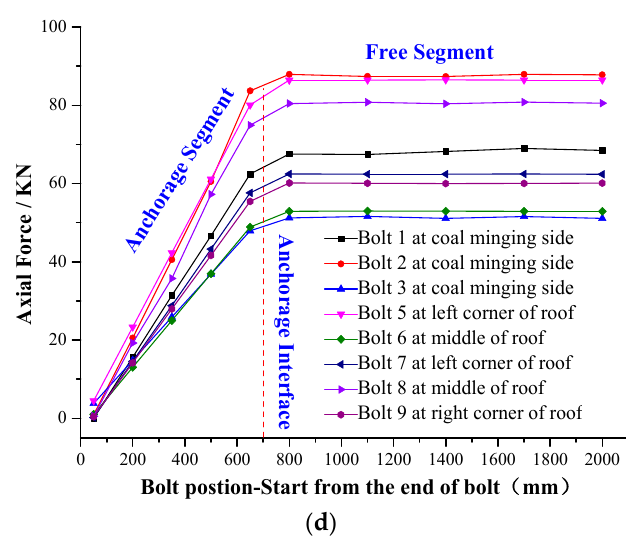
Figure 10. ( a ) Axial force variation curve of FBG force measuring bolt at coal mining side. ( b ) Axial force variation curve of FBG force measuring bolt at roof. ( c ) Axial force variation curve of FBG force measuring bolt at non coal mining side. ( d ) Axial force variation curve of FBG force measuring bolt at non coal mining side.